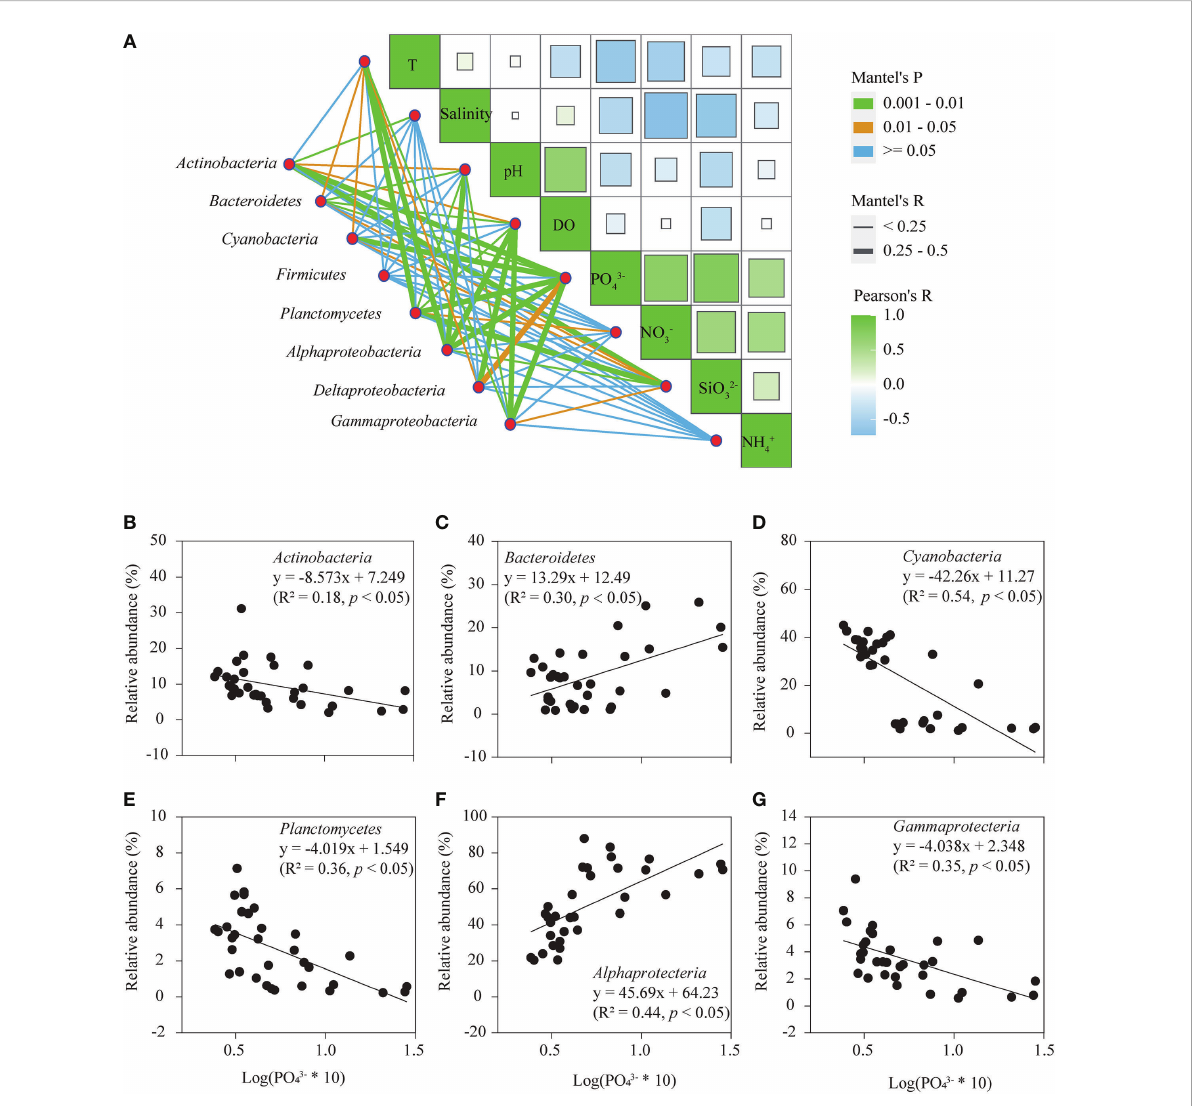
FIGURE 3 The relationships between environmental factors and their correlations with the community structure of the dominant bacterial (sub)phyla. Edge width means the R values of the Mantel ’ s statistic, and edge color represents the statistical signi fi cance based on 9,999 permutations (A) . The relative abundances of Actinobacteria (B) , Bacteroidetes (C) , Cyanobacteria (D) , Planctomycetes (E) Alphaproteobacteria (F) , and Gammaproteobacteria (G) along the phosphate